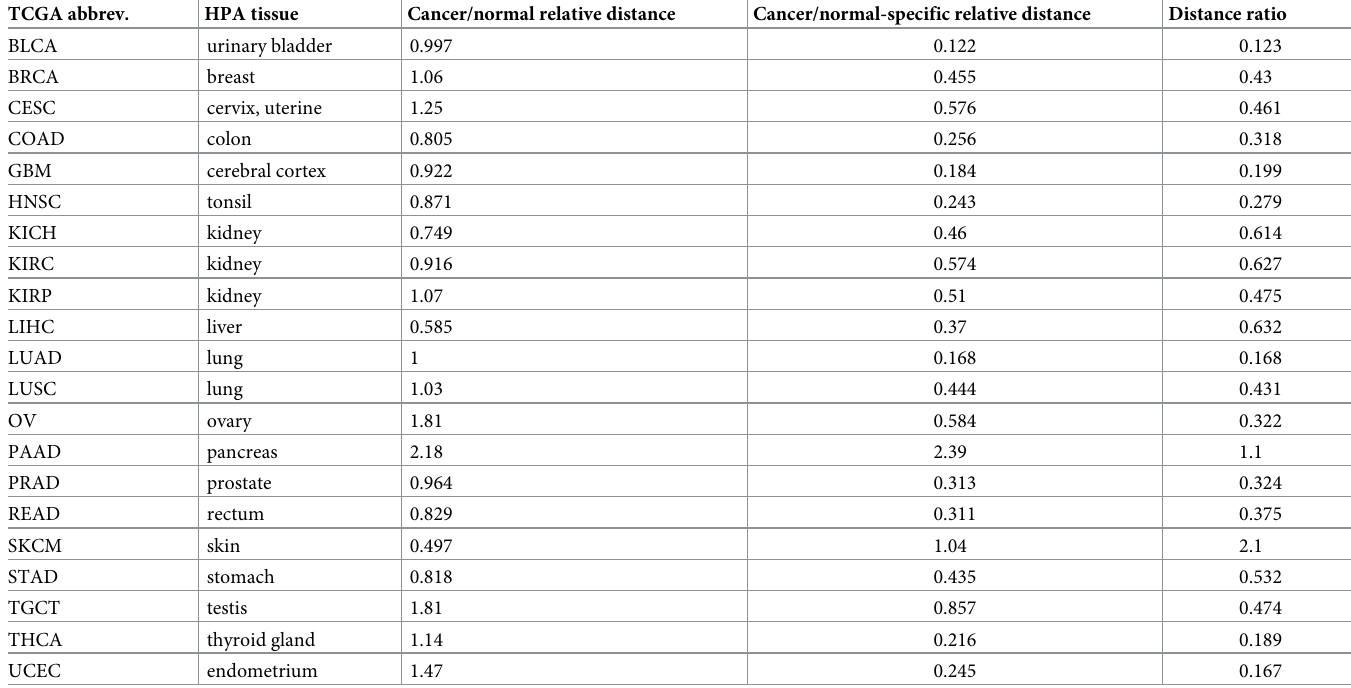
Table 3. Distances between each cancer type and the corresponding normal tissue in reduced principal component (PC) space. The Euclidean distance was computed between the projections of each cancer type and the associated normal tissue in the space spanned by the first two PCs of the mean gene expression matrix (as shown in Figs 1 and 2). The ‘Cancer/normal relative distance’ column contains the ratio of the distance between each cancer and normal tissue pair as visualized in Fig 1 to the aver- age distance between the cancer and all other cancers or normal tissues. The ‘Cancer/normal-specific relative distance’ column contains a similar distance ratio computed in the space spanned by the first two PCs of cancer-specific and normal tissue-specific mean expression values as visualized in Fig 2. The ‘Distance ratio’ column contains the ratio of the ‘Cancer/normal-specific relative distance’ to the ‘Cancer/normal relative distance’. TCGA